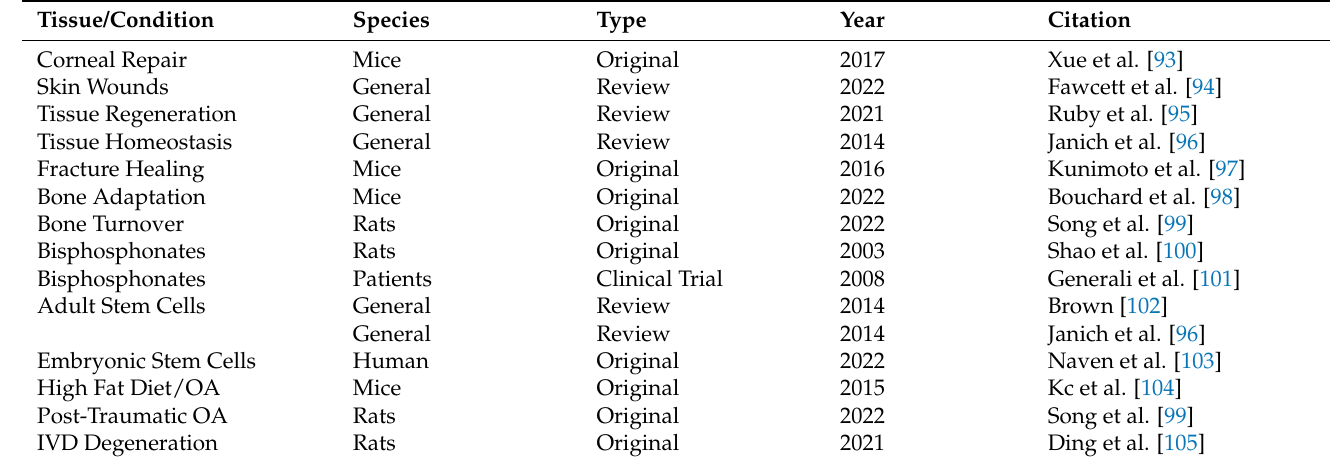
Table 2. Influence of circadian clocks and rhythms on MSK tissues and tissue